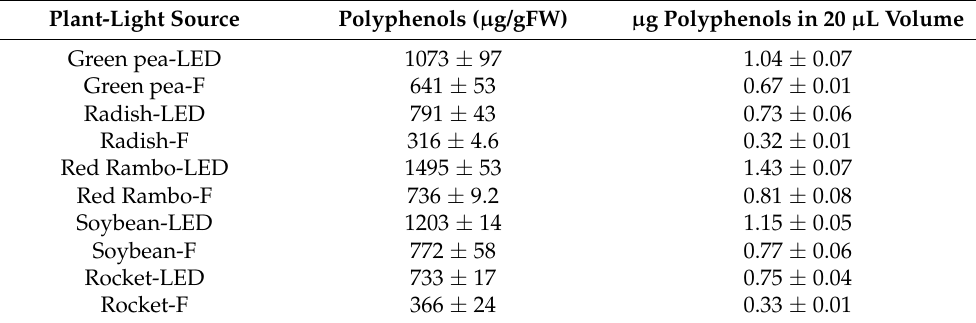
Table 4. Total polyphenol content in microgreen extracts and the content present in the sterilized 20 µ L extract matrix administered to cell